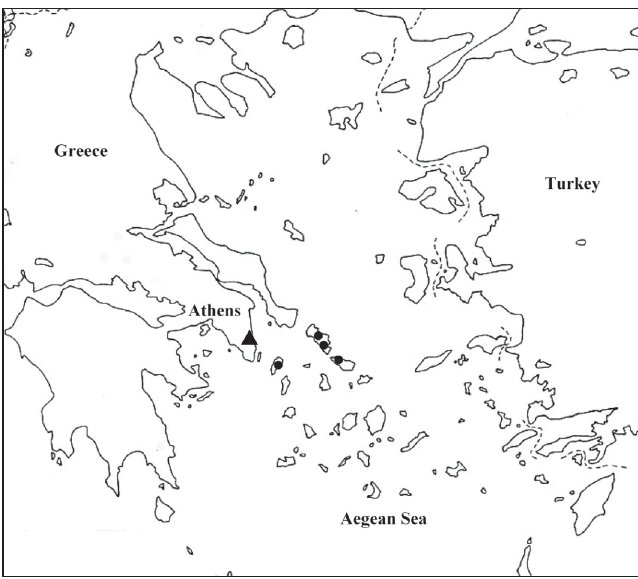
Figure 6. Total known distribution of Eupholidoptera kykladica (• lit- erature records, ▲ new record).